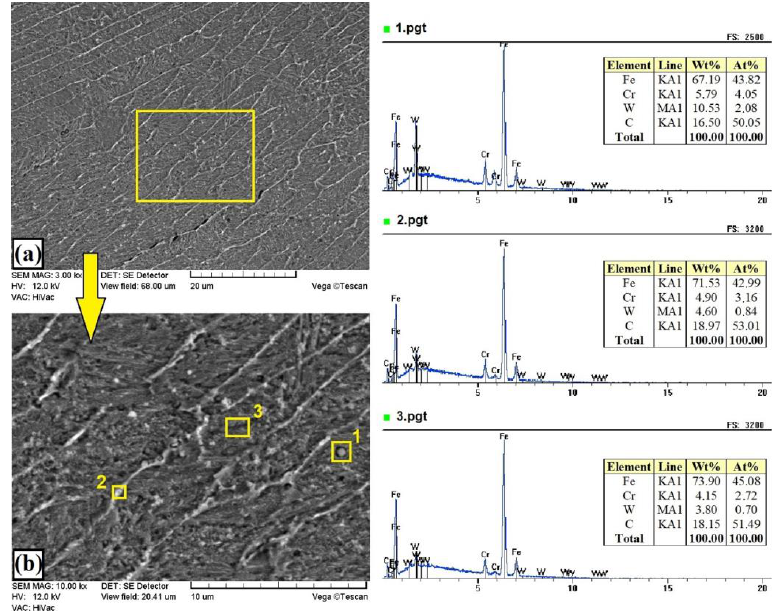
Figure 3. Microstructure of W–Cr coating produced using laser processing of precoat applied on steel substrate.